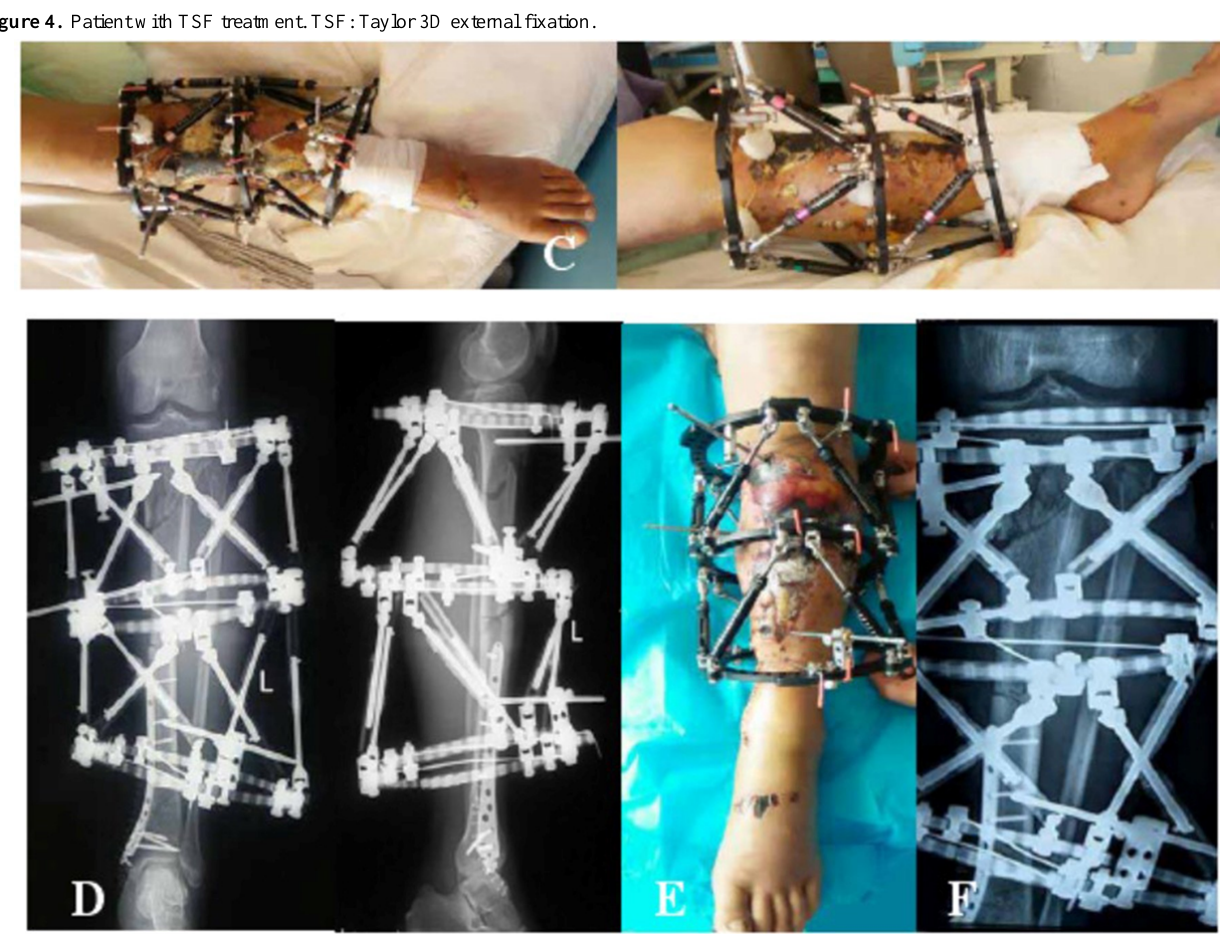
Figure 4. Patient with TSF treatment. TSF: Taylor 3D external